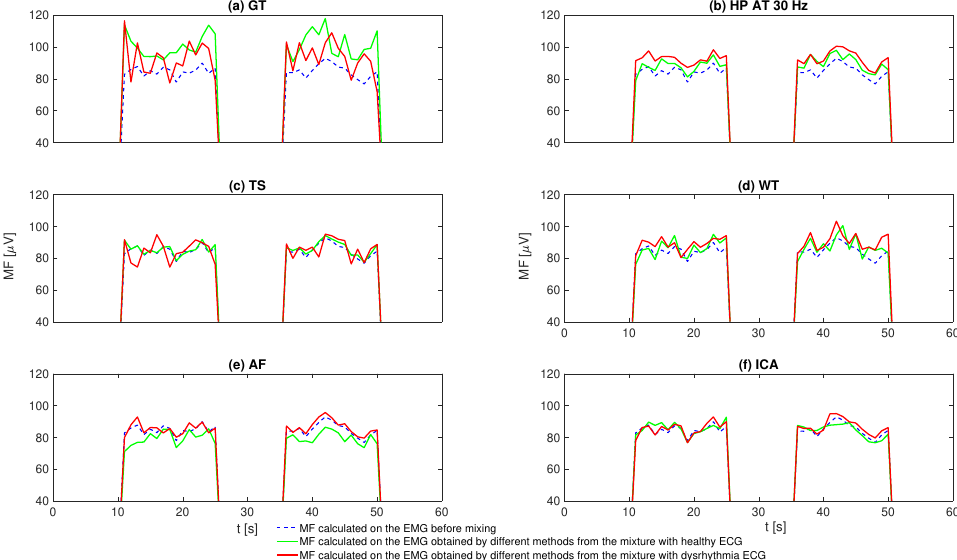
Figure 7. Example of the MF results calculated from the EMG signals obtained by different ECG removal methods: ( a ) MF results by GT; ( b ) MF results by HP; ( c ) MF results by TS; ( d ) MF results by WT; ( e ) MF results by AF; ( f ) MF results by